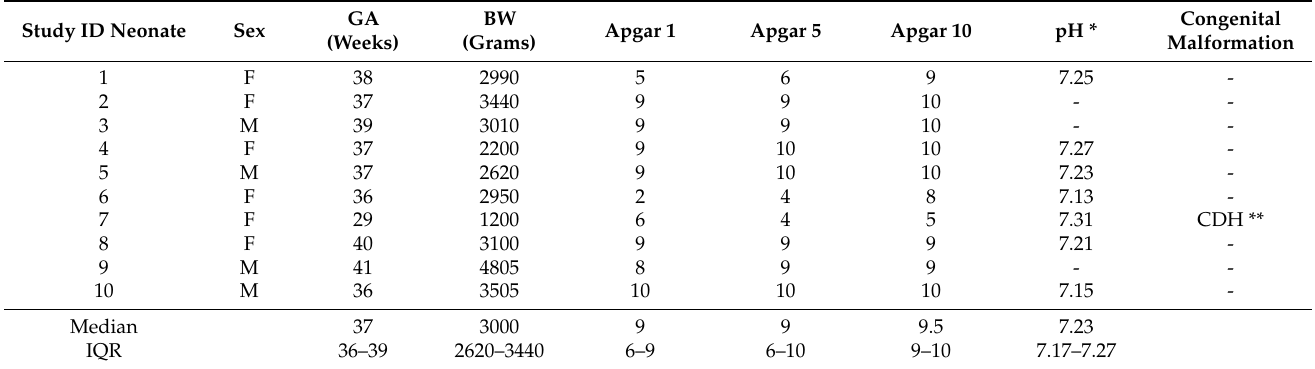
Table 2. Characteristics of the included neonates at birth.